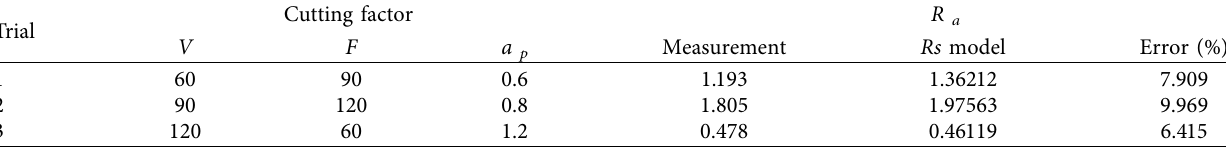
Table 6: RS model’s accuracy was tested using this collection of